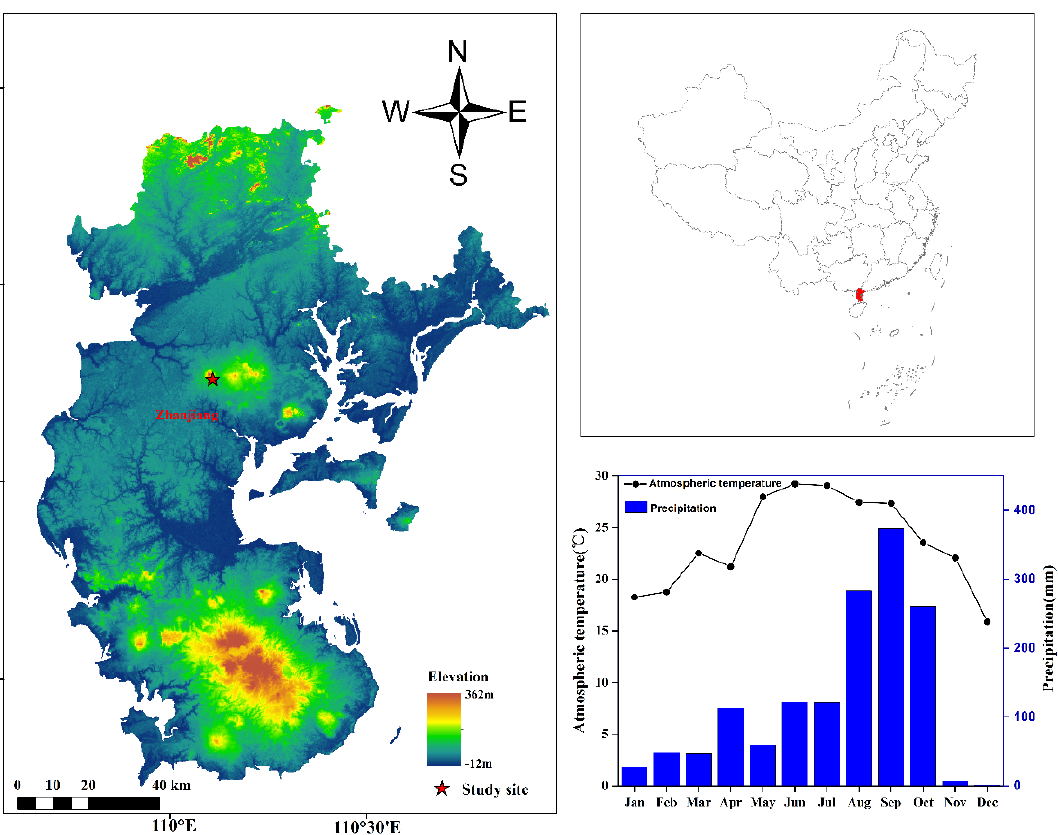
Figure 1. Location of the study area, topography, and mean monthly temperature and precipitation during the monitoring period.